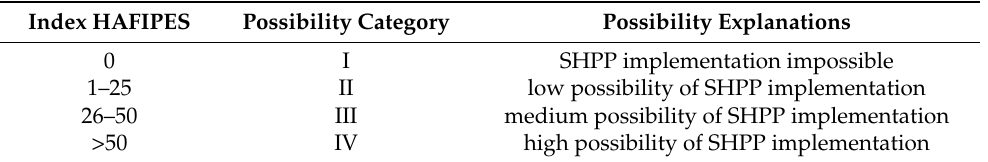
Table 3. HAFIPES index ranges for the possibility of SHPP implementation